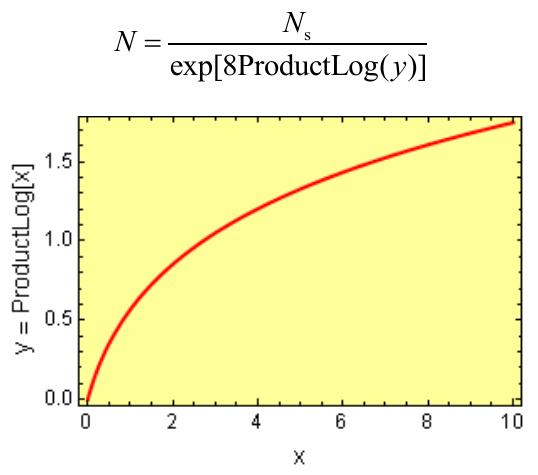
Figure 2. Graphic representation of the ProductLog[ y ] function for y 